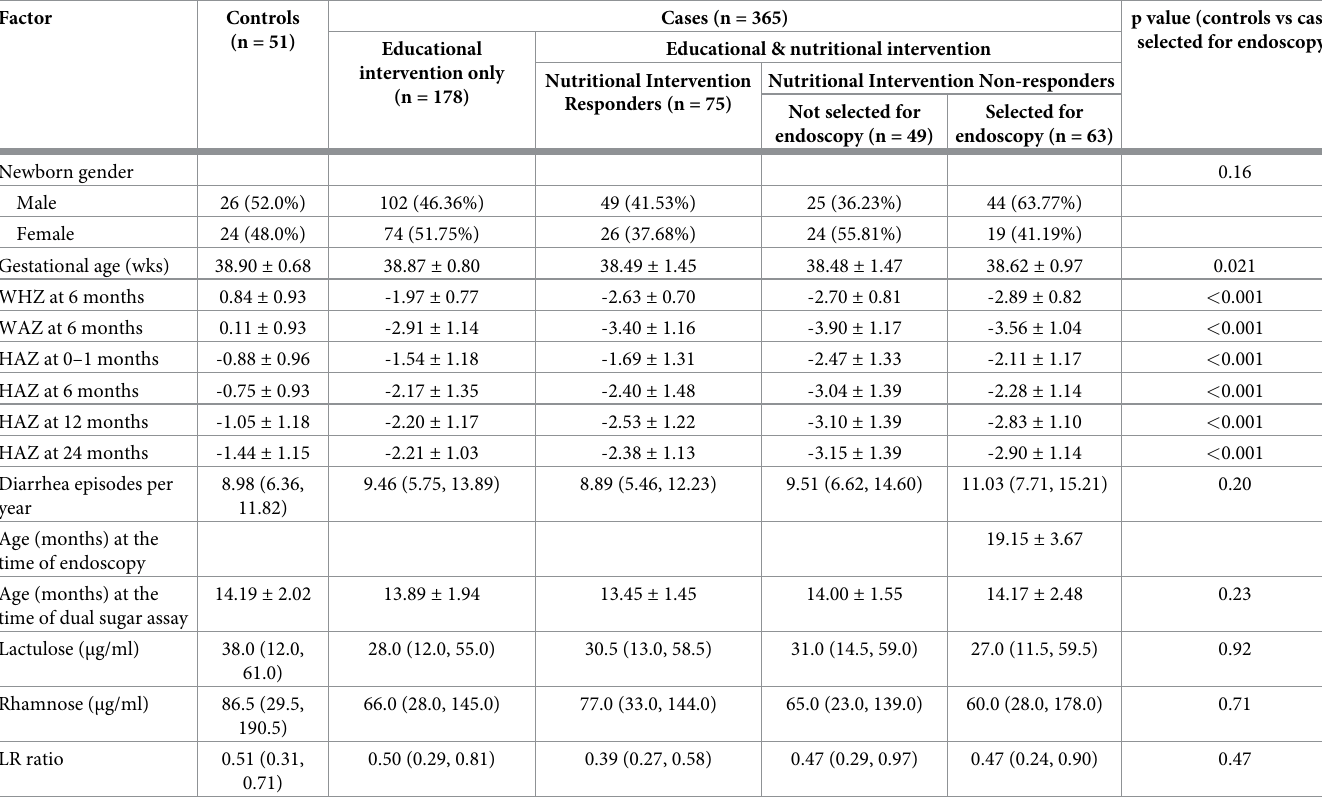
Table 1. Demographics of the study